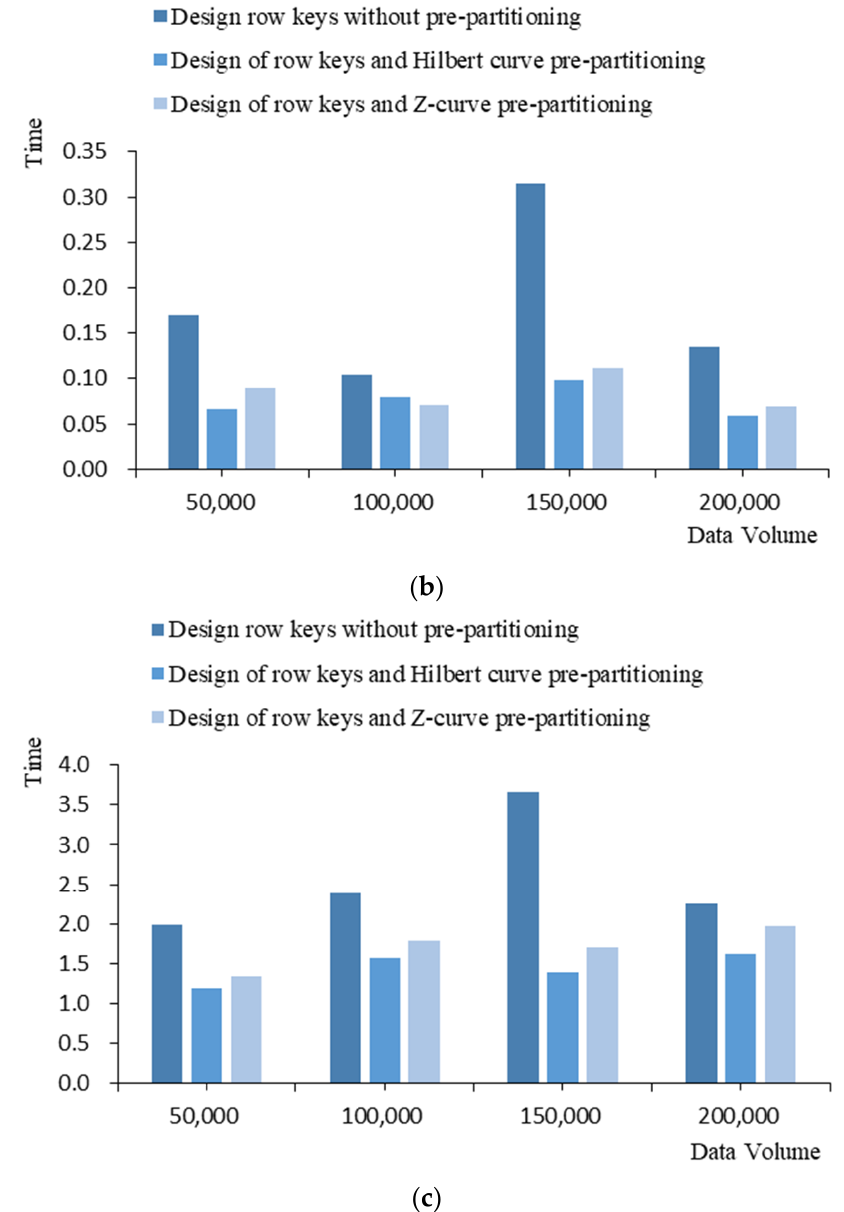
Figure 12. Retrieval speed comparison chart. ( a ) Single-trajectory data retrieval, ( b ) Range trajectory object data retrieval, ( c ) Regional trajectory object data retrieval.